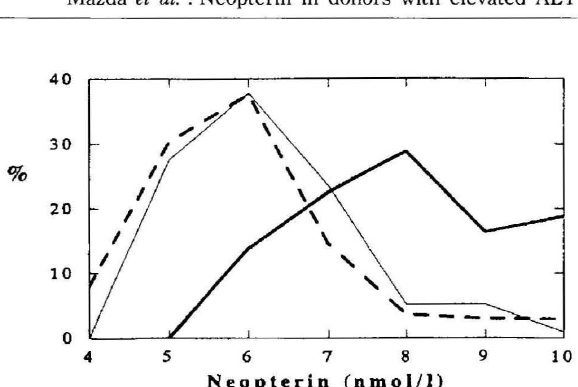
Figure 1. Frequency distributions of plasma neopterin levels in three groups.